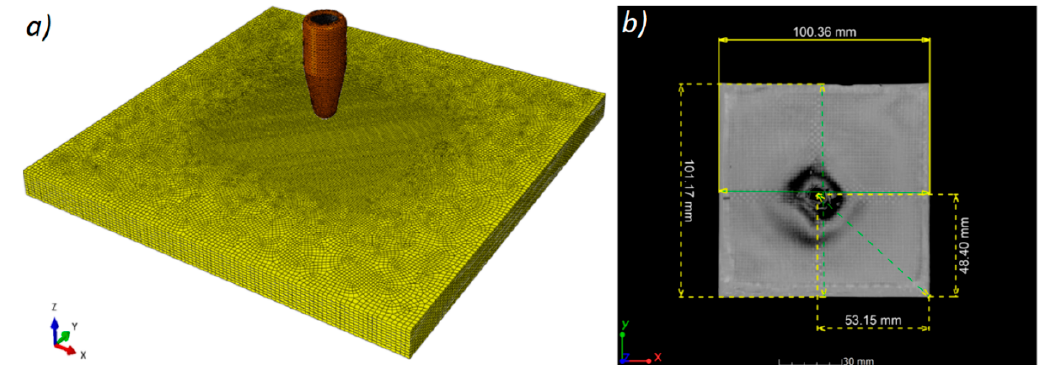
Figure 17. Discretization of the elements of a laminate board and a 9 mm × 19 mm projectile ( a ) and ( b ) boundary conditions for the projectile impact point determined on the basis of the XCT reconstruction.